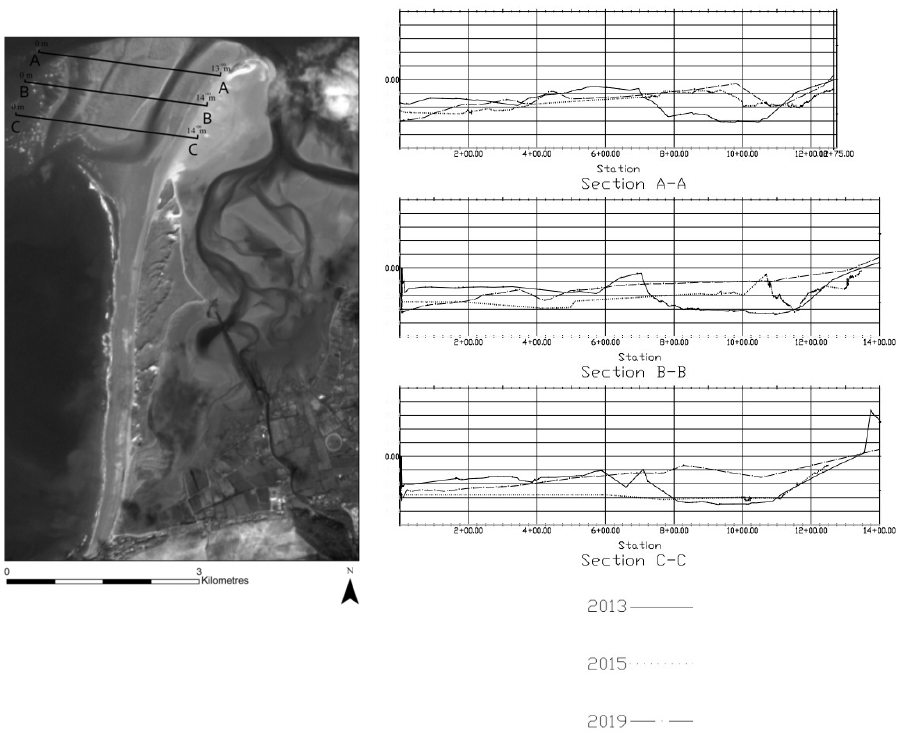
Figure 6. Survey cross section comparison.